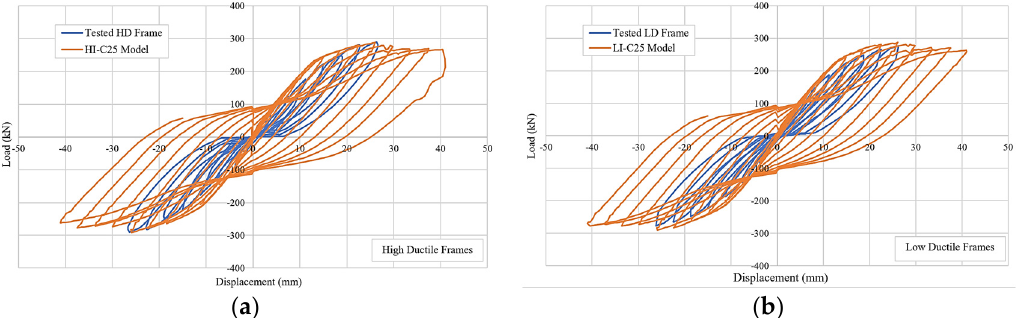
Figure 15. Load-deflection responses of the tested frames and models: ( a ) HD frames; ( b ) LD frames.